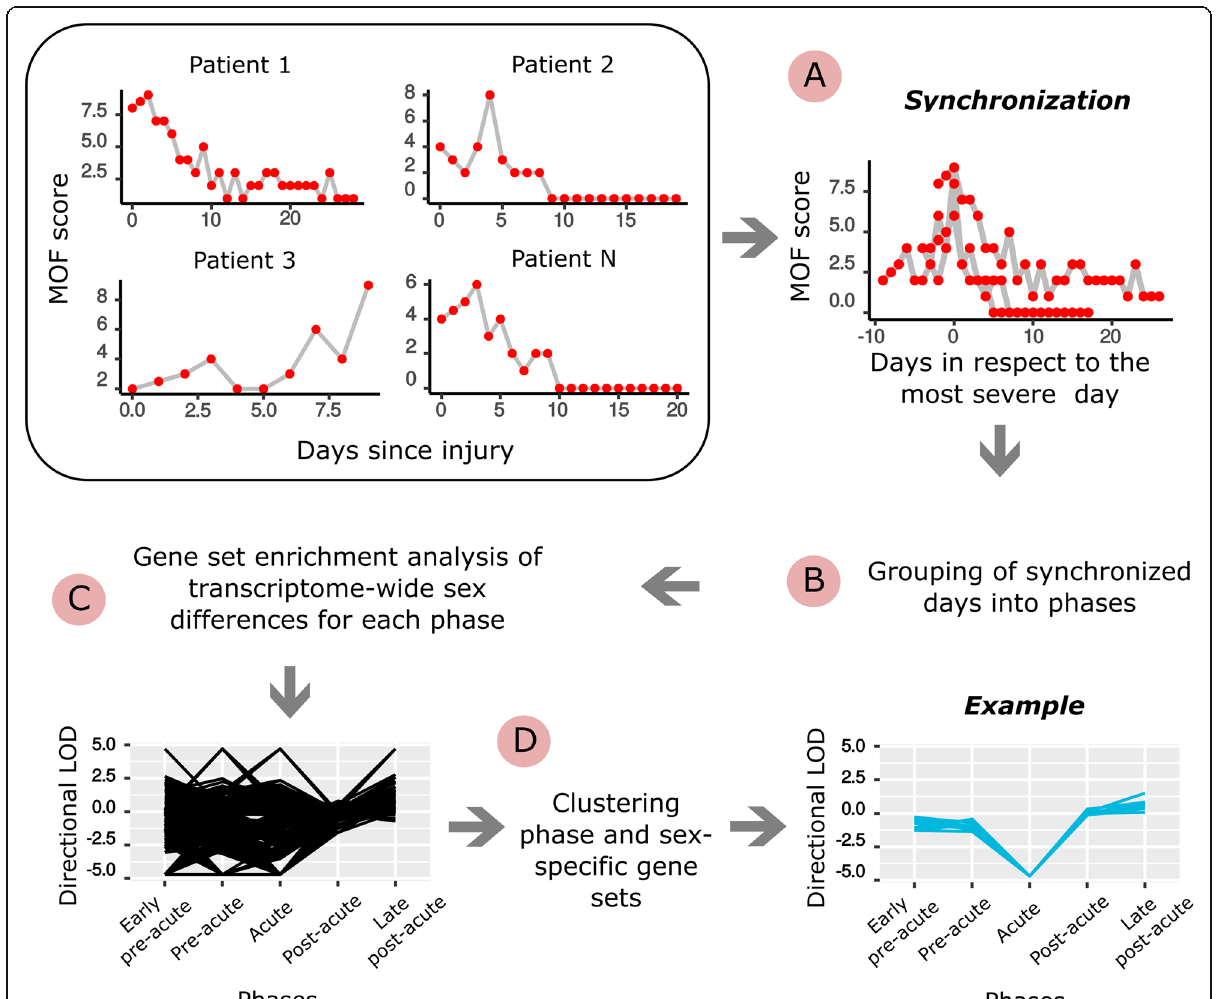
Fig. 1 The workflow. a Time series expression profiles of the patients were synchronized according to their day of maximal MOF (multiple organ failure) (denoted as acute phase). b The investigated days before, at and after the acute phase were grouped into major temporal phases. c Gene expression analysis provided sets of differentially expressed genes between male and female patients d The identified gene sets were grouped according to their temporal appearance and the similar cellular processes they